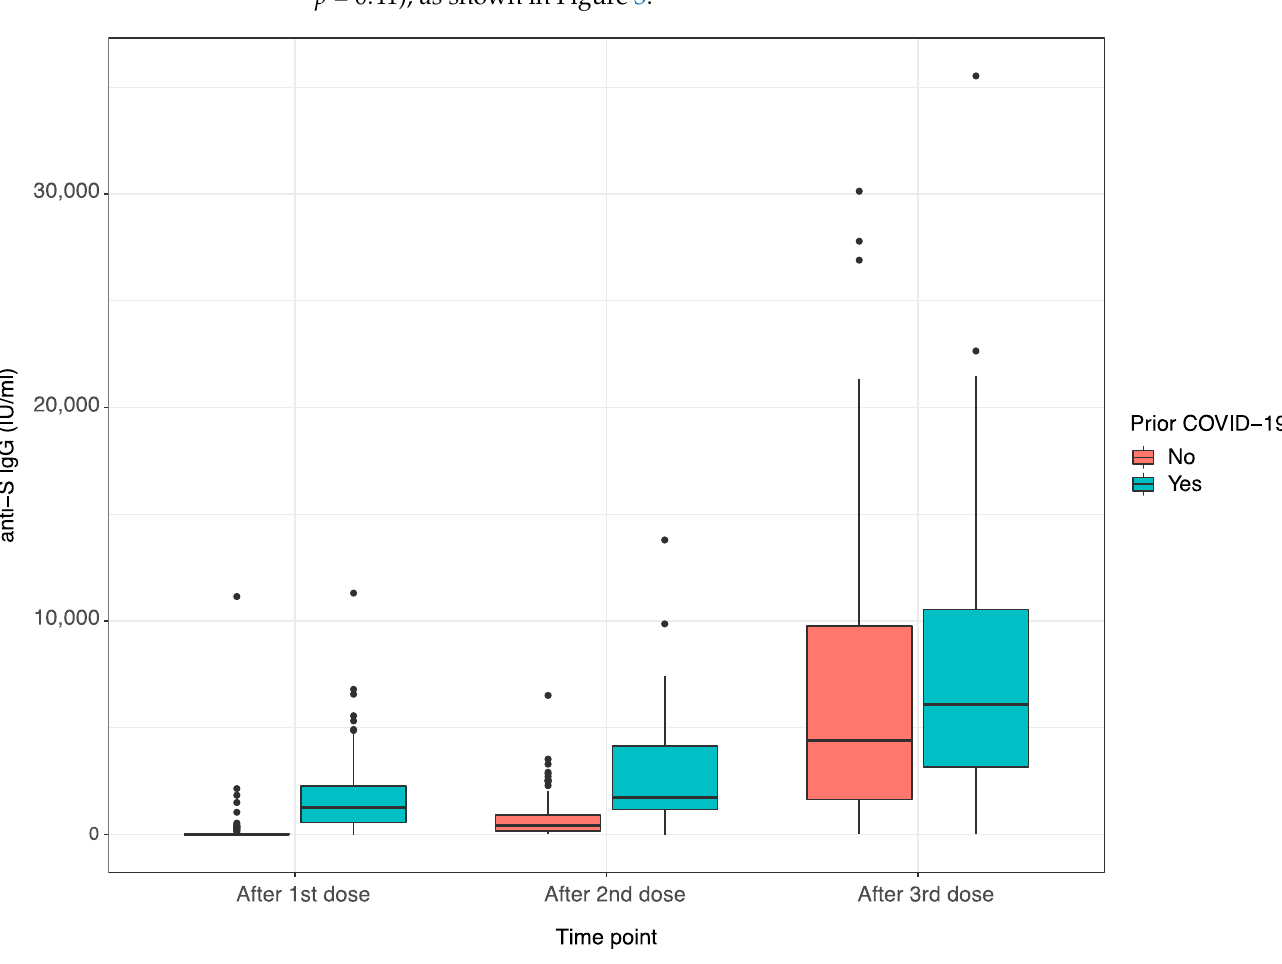
Figure 3. Anti-S IgG levels after subsequent vaccine dose regarding prior COVID-19 infection.